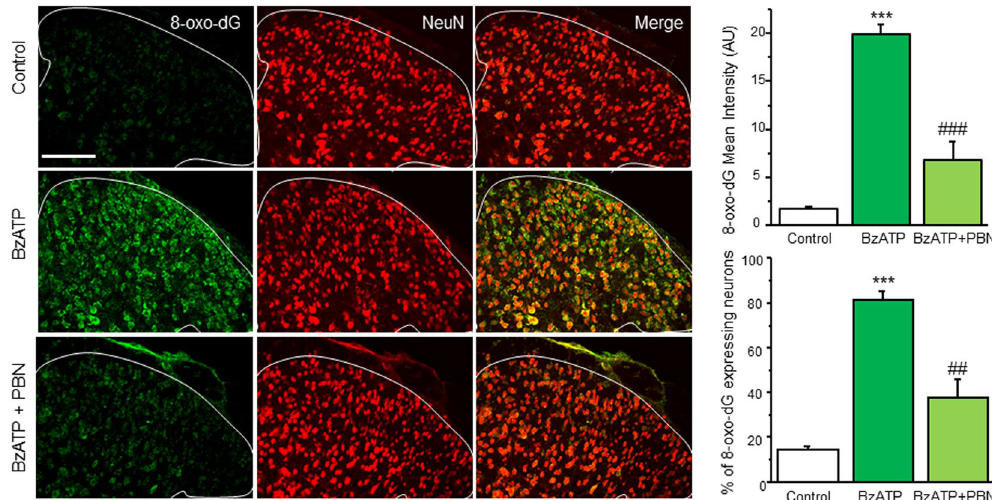
Figure 6. BzATP increases 8-oxo-dG in spinal cord dorsal horn neurons in vivo . Left panel: Confocal images of BzATP-induced oxidative DNA damage as marked by 8-oxo-dG (green) with and without PBN pre-treatment. Spinal cords were double stained with NeuN, a neuronal marker (red). Top right panel: Summary of 8-oxo-dG intensity in BzATP-induced oxidative DNA damage. Bottom right panel: Percent colocalization of 8-oxo-dG expressing neurons. Values represent mean ± SEM, n = 3–5. *** P < 0.001 when compared to control, ## P < 0.01, ### P < 0.001 when compared to BzATP by the one-way ANOVA. Scale bar 100 µ m.